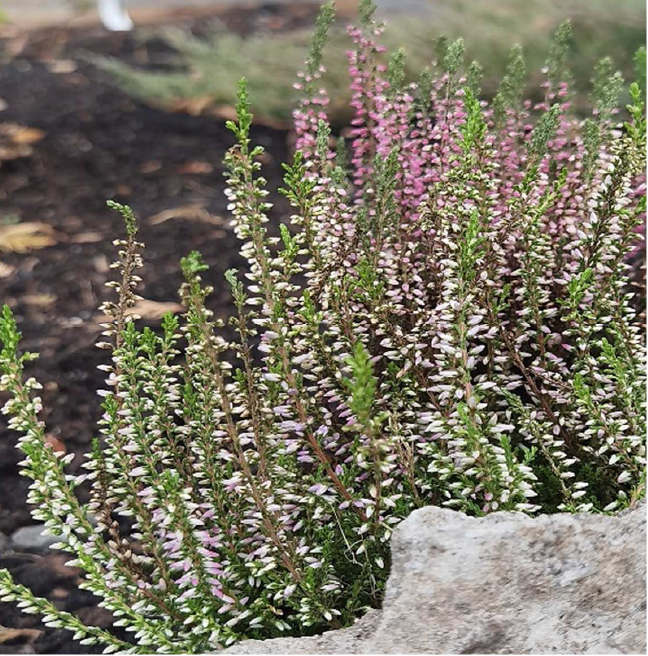
Figure 1. Young heather plant in Botanical Garden of Ural Branch of the Russian Academy of Sciences.